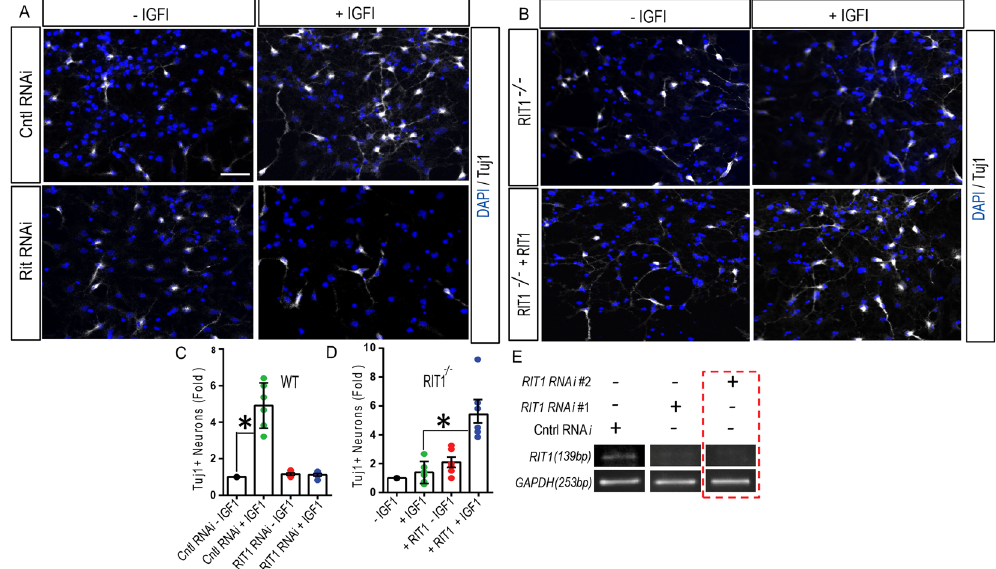
Figure 4. RIT1 knockdown impairs IGF-1-dependent neural induction of HNPCs. ( A ) WT HNPC cultures were left untreated (-IGF1) or treated with IGF-1 (50 ng/ml, 24 h) following infection with either control (Cntl) or RIT1-RNAi lentivirus and co-immunostained with Tuj1 ( white, pseudo color ) and DAPI (nuclei; blue ) (Scale bar 10 μ m). ( B ) RIT1 − / − HNPCs were transfected with or without Myc-tagged RIT1 and co-immunostained with Tuj1 ( white, pseudocolor ) and for nuclei (DAPI: blue ) following vehicle or IGF-1 stimulation (50 ng/ml, 24 h). ( C , D ) Quantification of Tuj1 + cells (n = 500 cells from 5–6 random fields) in HNPCs following either lentiviral-mediated RIT1 knockdown, or gene rescue in RIT1 − / − HNPCs, with or without IGF-1 stimulation ( * p < 0.05, one-way ANOVA). ( E ) RT-PCR analysis of lentiviral-mediated RIT1 RNAi silencing efficiency in HNPCs. RIT1#2 RNA i was used in all subsequent